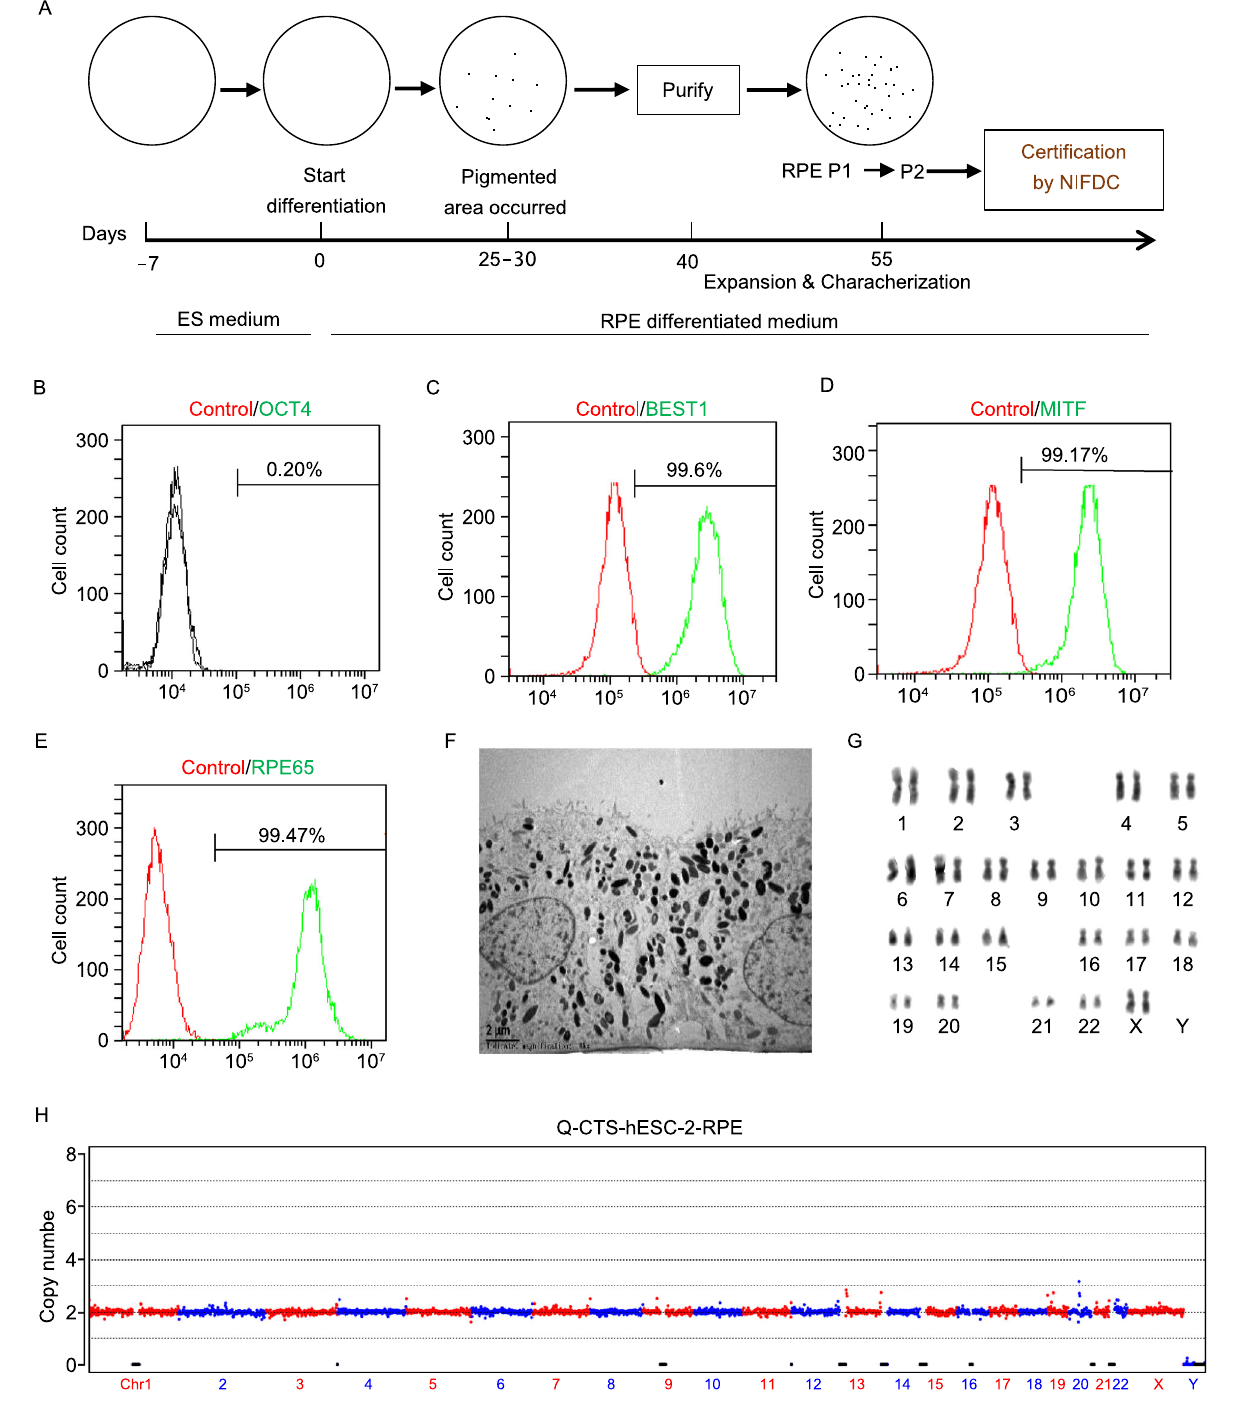
Figure 1. Characterization of Q-CTS-hESC-2-RPE cells . (A) Timecourse of the differentiation of Q-CTS-hESC-2-RPE cells. Flow cytometric analysis the expression of OTC4 (B) and key RPE markers BEST1 (C), MITF (D) and RPE65 (E). (F) Ultrastructure of the Q-CTS-hESC-2-RPE cells. Scale bar = 2 μ m. (G) Karyotype analysis of Q-CTS-hESC-2-RPE cells. (H) Whole-genome